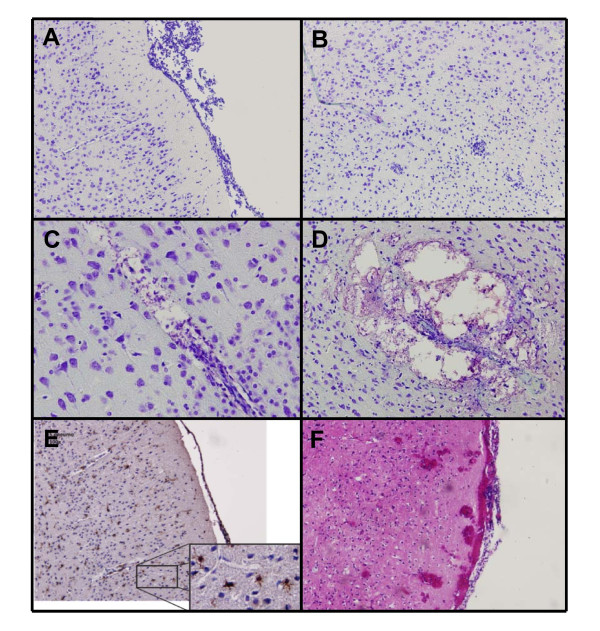
Brain pathology of mice with pneumococcal meningitis. Nissl staining of the cortex of mice infected with S. pneumoniae, showing extensive leptomeningeal inflammatory infiltrate (A; 100× magnification), perivascular lymphocytic cuffing (B; 100× magnification), perivascular lymphocytic infiltration combined with bacterial overgrowth (C; 200× magnification) and further bacterial overgrowth combined with perivascular necrosis (D; 100× magnification). Iba-1 immunohistochemistry revealed microglial activation (E; 100× magnification). Hematoxylin and eosin staining showed subarachnoidal and cortical hemorrhages (F; 100× magnification).